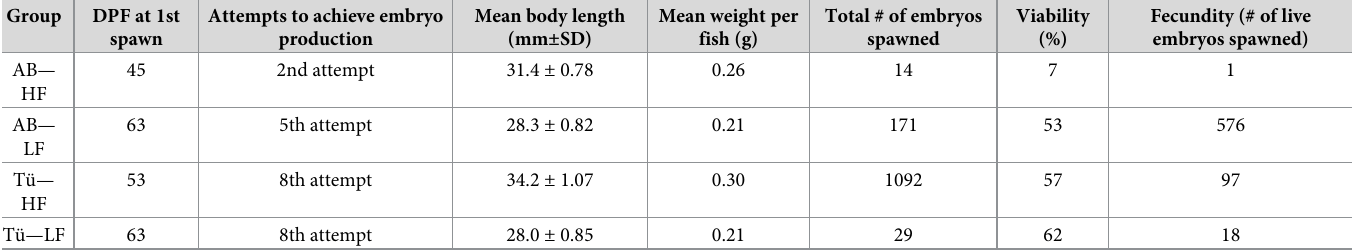
Table 1. Initial reproductive performance of fish from LF and HF. Values recorded at first successful group spawn of 35 fish. Fish were allowed to spawn for a total of 30 minutes. Group DPF at 1st Attempts to achieve embryo spawn production